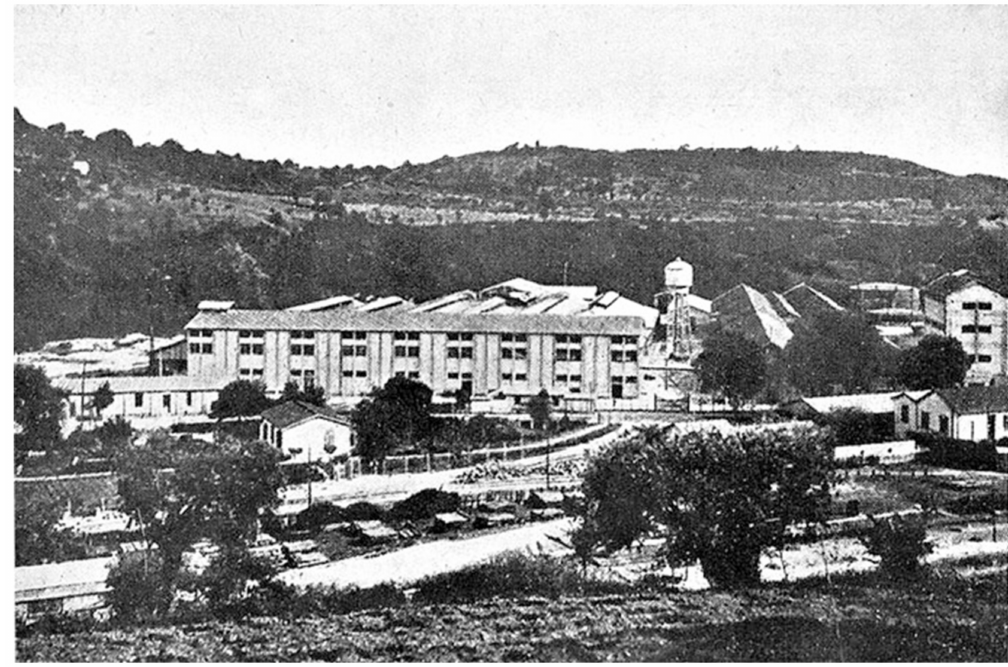
Figure 3. Ammonia factory at Nera Montoro, Italy. Courtesy Casale